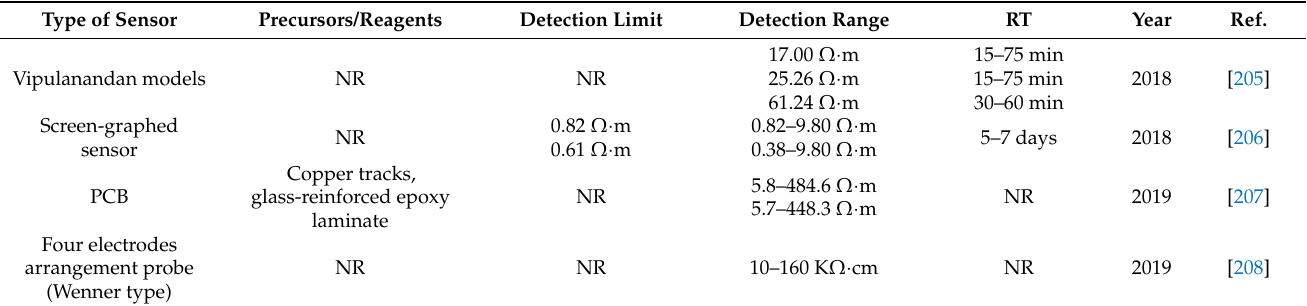
Table 3. Resistivity sensors reported since 2016.